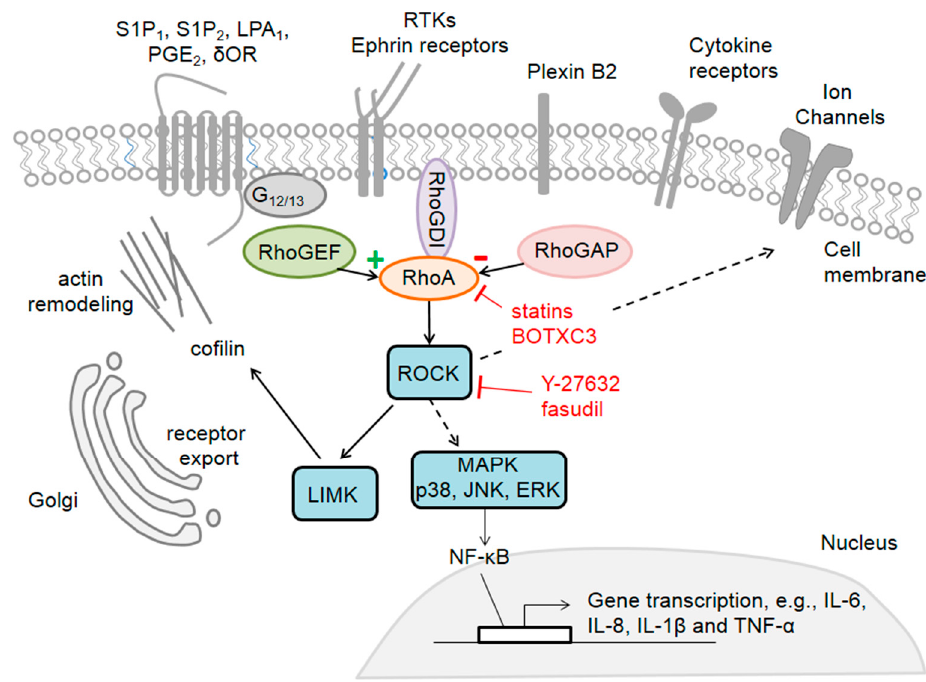
Figure 1. The family member RhoA, effectors and activators in sensory neurons. RhoA can be activated via different receptors, such as GPCRs (G-protein coupled receptors), RTKs (receptors of the tyrosine kinase family), cytokine receptors or ion channels. RhoA activity is regulated by specific proteins: GEFs (guanine nucleotide exchange factors) which promote its active state and GAPs (GTPase activating proteins) which turn it into an inactive state. By regulating various downstream effectors, RhoA elicits changes in the actin cytoskeleton and these effects can be pharmacologically modulated by inhibitors like Clostridium botulinum C3 toxin (BoTXC3) or fasudil.